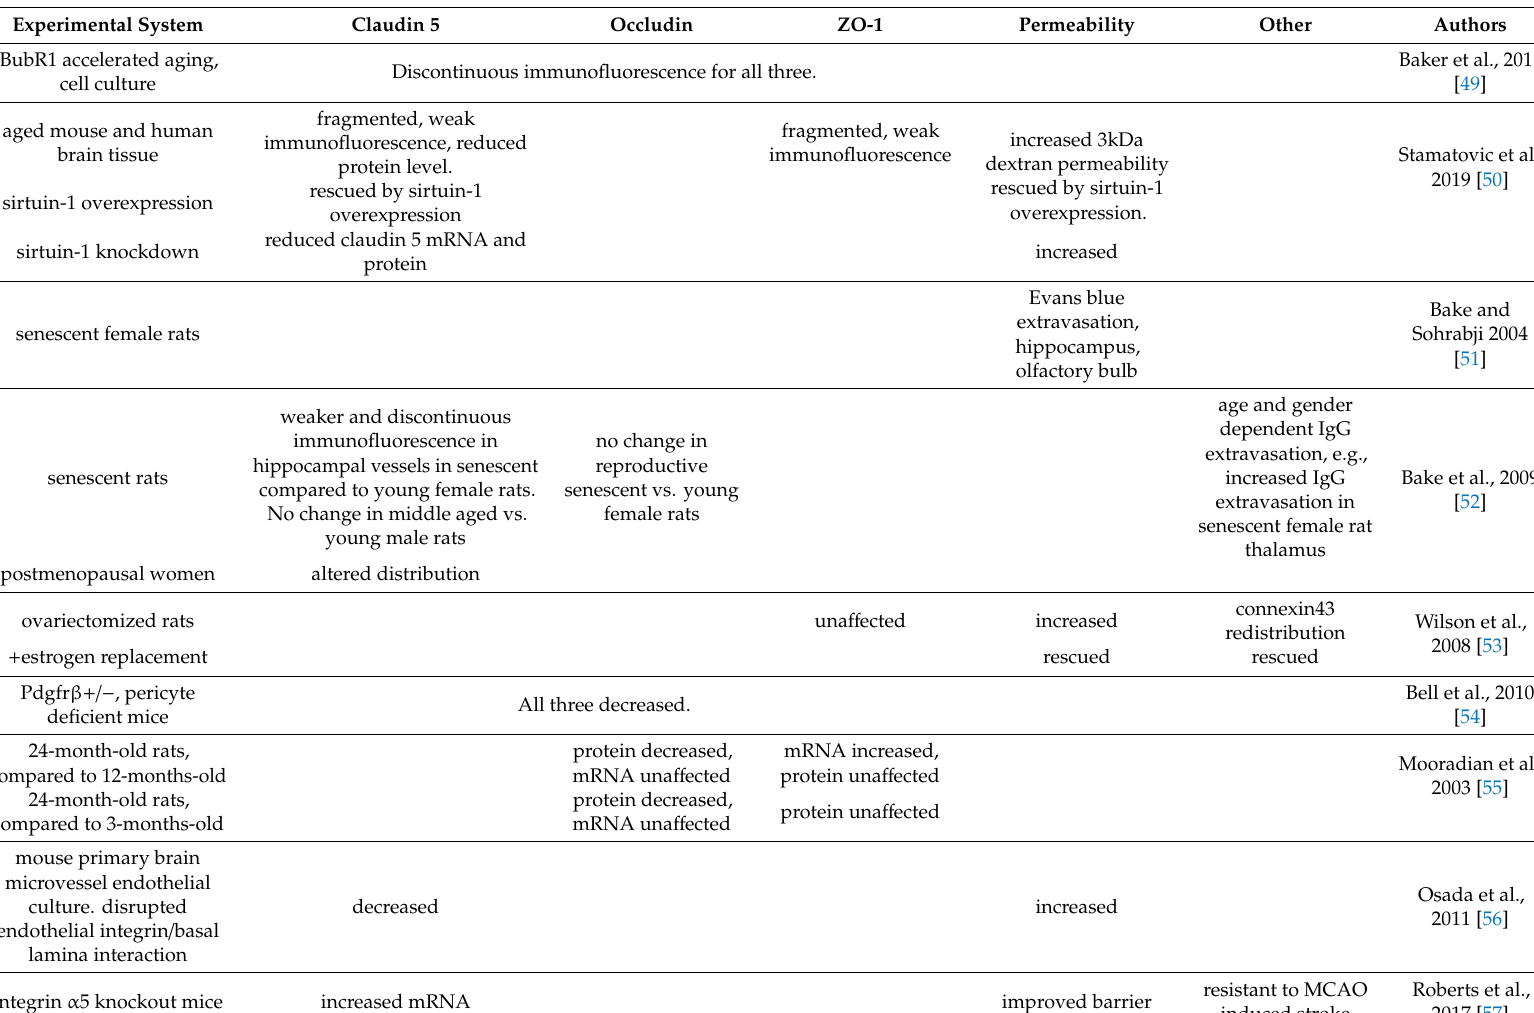
Table 1. Blood–brain barrier (BBB) function and junctional proteins in